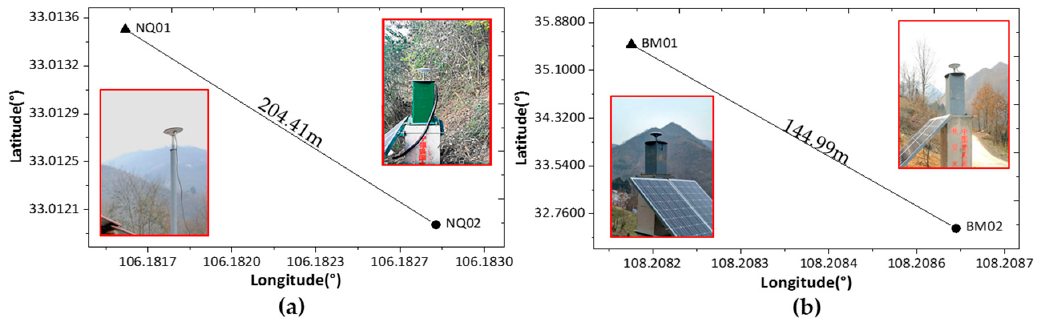
Figure 6. The distribution of stations for both sites: ( a ) reference station (NQ01) and rover station (NQ02); ( b ) reference station (BM01) and rover station (BM02).